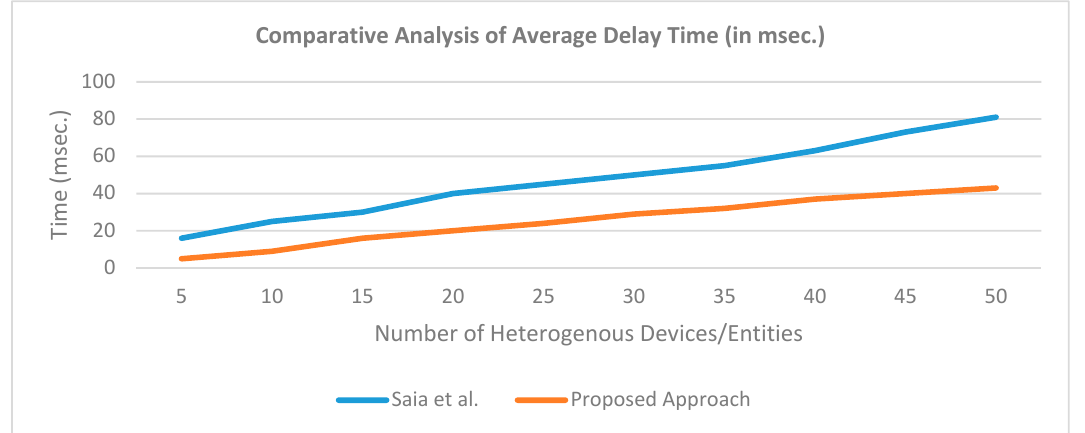
Figure 42. Comparative analysis of proposed work with existing using average delay time variations in consensus building.